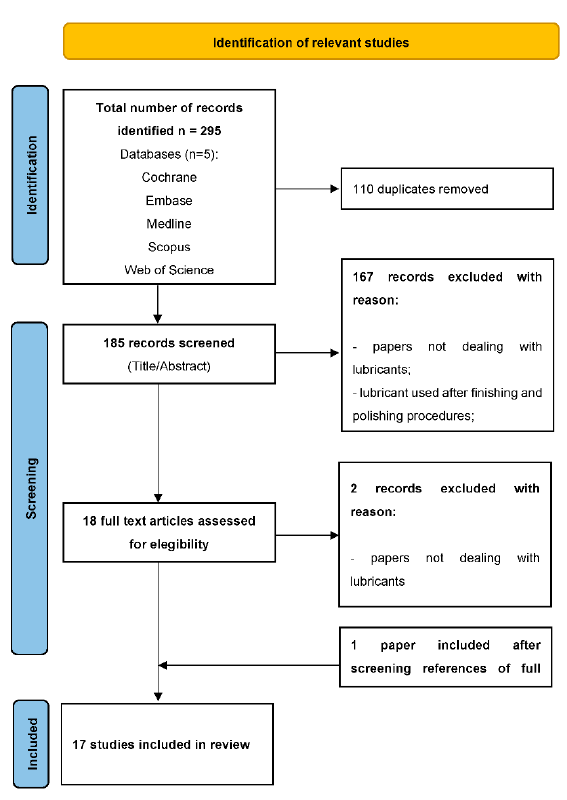
Figure 1. Flow chart showing the process followed for the identification of relevant studies. The first title and abstract screening obtained 295 records. After the revision and identification of